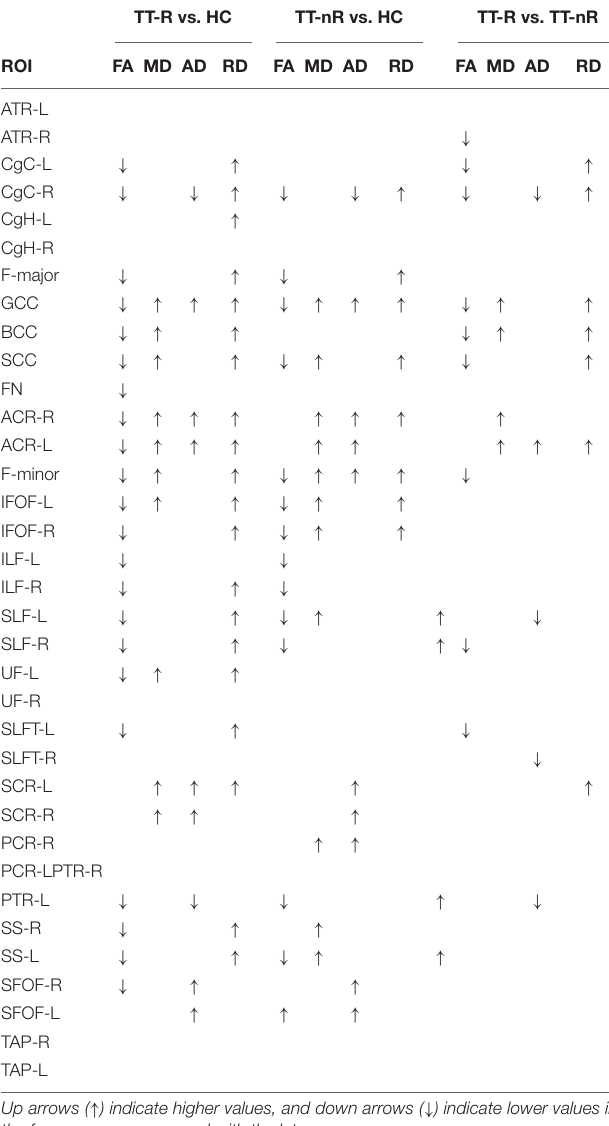
TABLE 2 | ABA-TBSS analysis results. TT-R vs.